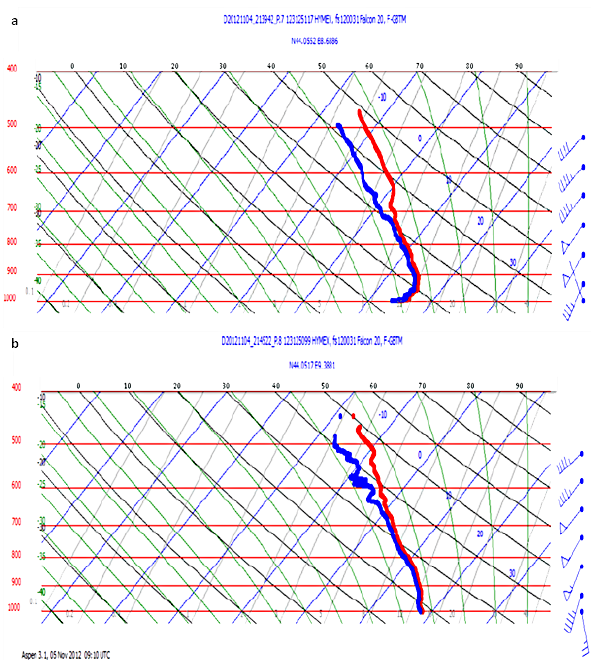
Figure 21. Vertical profile from the two dropsondes deployed by the Falcon flight over the Gulf of Genoa at (a) DS1 (44.055 ◦ N, 8.689 ◦ E) at 21:40UTC, and (b) DS2 (44.052 ◦ N, 9.388 ◦ E) at 21:45UTC. Courtesy of Julien Delanoe (LATMOS/IPSL/UVSQ,